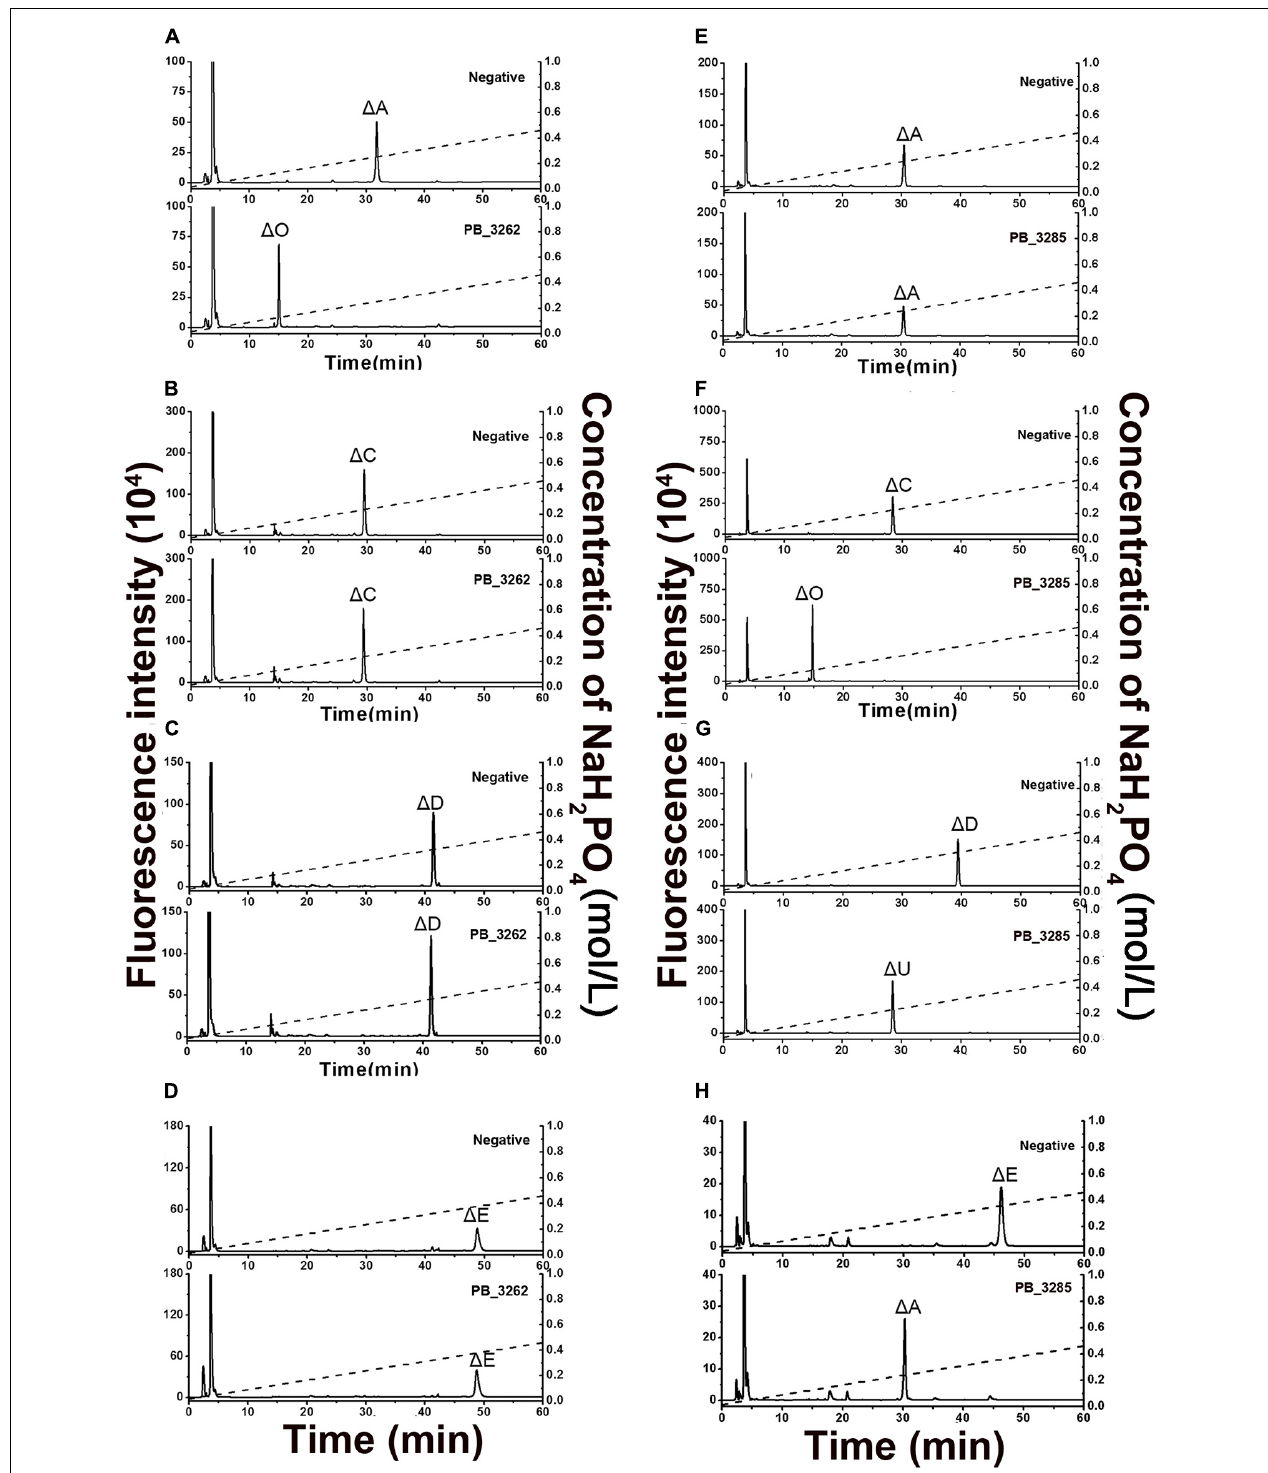
FIGURE 3 | Product analysis of various unsaturated CS disaccharides treated with PB_3262 and PB_3285. Unsaturated CS disaccharides (cid:49) A (A,E) , (cid:49) C (B,F) , (cid:49) D (C,G) and (cid:49) E (D,H) were treated with inactivated (top) or original (bottom) PB_3262 (A–D) and PB_3285 (E–H) . All of the products were labeled with 2-AB and then analyzed using anion-exchange HPLC as described under section “Materials and Methods.” The elution positions of the standard disaccharides are indicated: (cid:49) O ( (cid:49) HexUA1–3GalNAc), (cid:49) A [ (cid:49) HexUA1–3GalNAc(4S)], (cid:49) C [ (cid:49) HexUA1–3GalNAc(6S)], (cid:49) D [ (cid:49) HexUA(2S)1–3GalNAc(6S)], (cid:49) E [ (cid:49) HexUA1–3GalNAc(4S,6S)] and (cid:49) U [ (cid:49) HexUA(2S)1–3GalNAc]. The peaks detected around 3 min in the figures are derived from fluorescent labeling reagents.